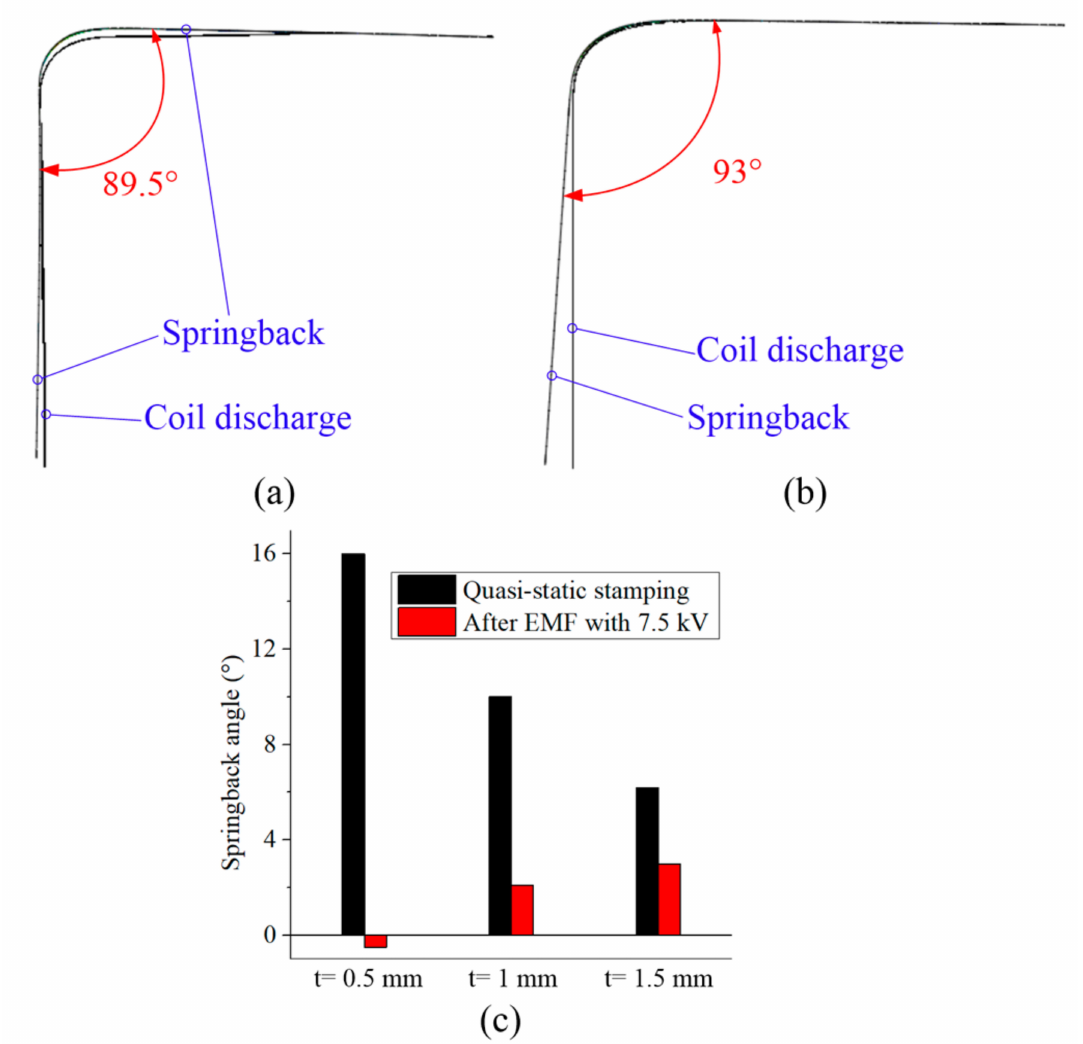
Figure 19. Springback angle with di ff erent sheet thickness: ( a ) the sheet thickness is equal to 0.5 mm and its deformation shape, ( b ) the sheet thickness is equal to 1.5 mm and its deformation shape, ( c ) comparison between the quasi-static stamping and